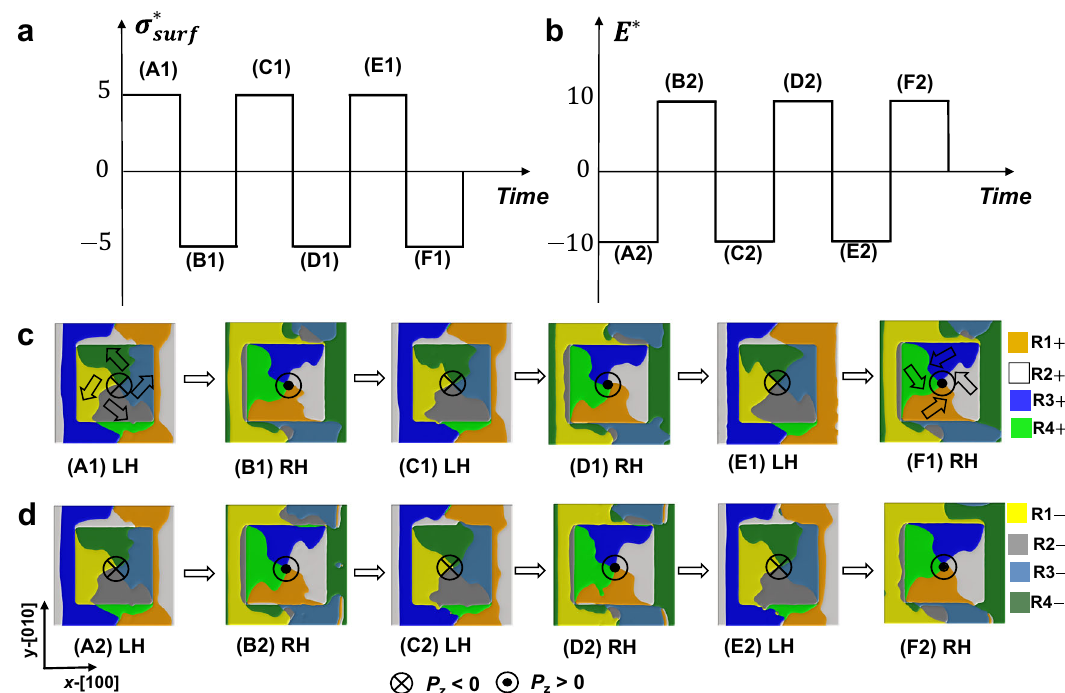
Fig. 6 Reversible control of vortex chirality via alternating external stimuli. a Schematic of surface charge application. b Schematic of electric fi eld application. c Reversible vortex chirality evolution under the stimuli presented in ( a ). d Reversible vortex chirality evolution under the stimuli presented in ( b ). The * is a normalized value, E * = E × 0.192